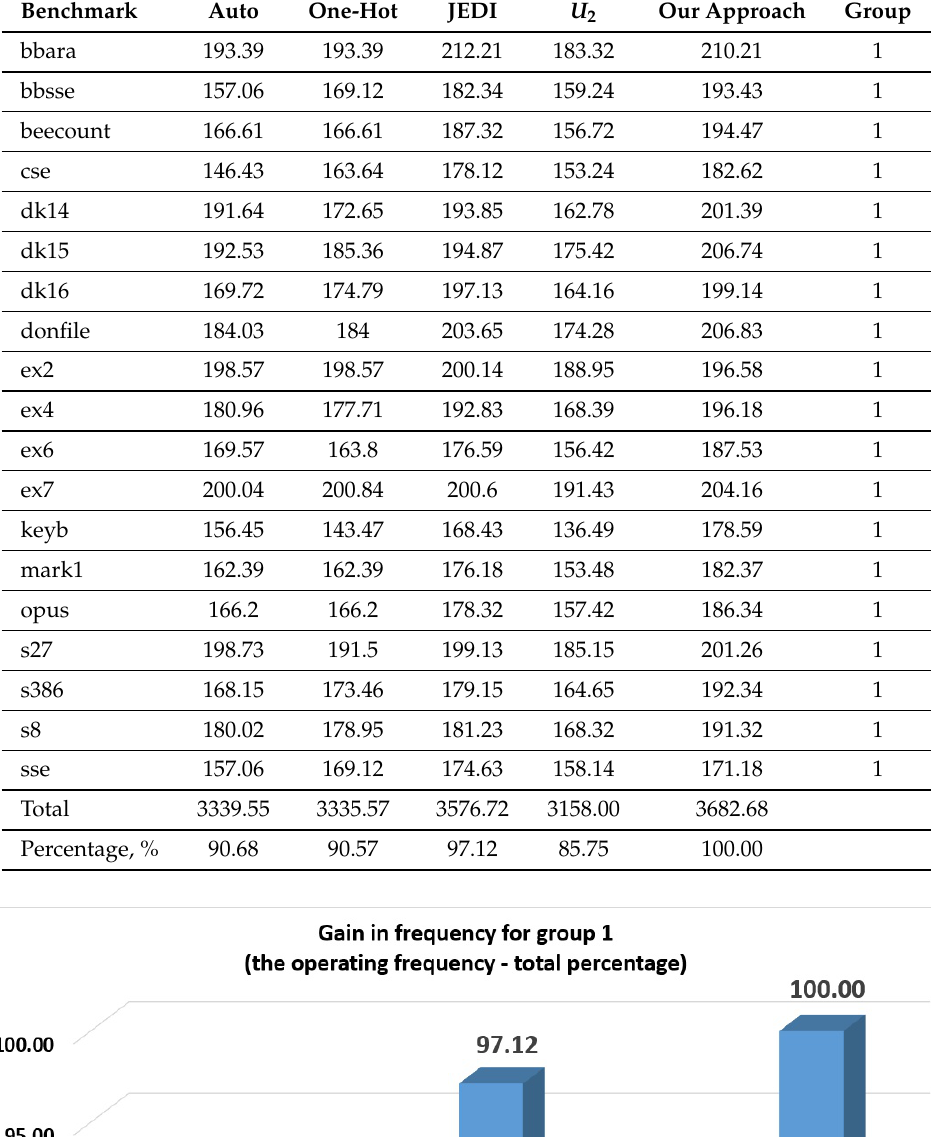
Table 13. Gain in frequency for group 1 (the operating frequency).